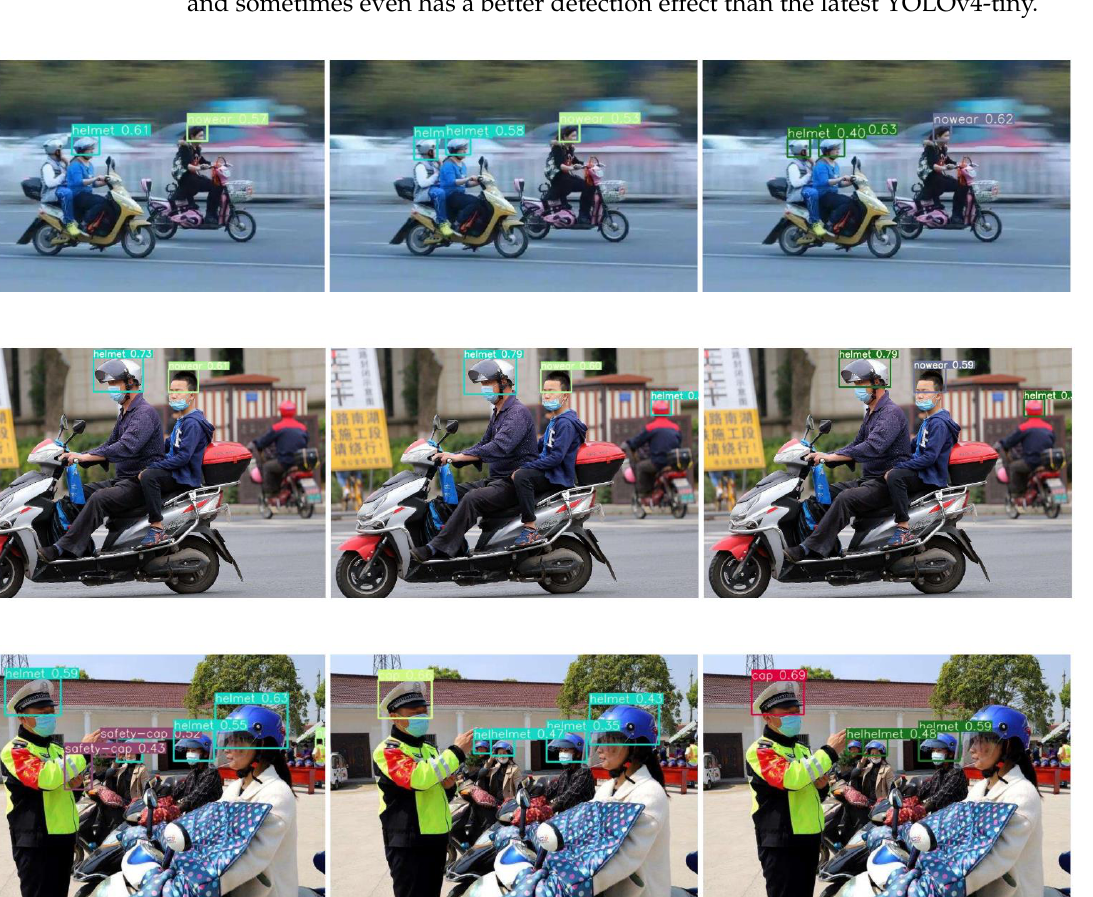
( b ) The curves of F1 Figure 6. The curves of F1 and mAP in the different models. 4.2.3. Result Comparison with Other Detection Models To prove each algorithm’s generalization performance, we compare and analyze dif- ferent evaluation indexes for different algorithms on the test set, which are shown as shown in Table 4. From Table 4, we can draw the following conclusions. On the test set, compared with the YOLOv3-tiny, SAS-YOLOv3-tiny improves R from 75.4% to 80.9% im- proves mAP from 74.6% to 80.3%, improves F1 from 72.9% to 75.2% and reduces the size of weight file from 69.5 MB to 46.9 MB, which mainly benefits from the use of SR module based on channel attention and SPP module, the application of three-scale prediction method, and the introduction of CIoU loss. Compared with the latest YOLOv4-tiny, SAS- YOLOv3-tiny improves R from 80.0% to 80.9% and improves mAP from 78.9% to 80.3%, but P and F1 decreases to some extent. The main reason is that the idea of the Cross Stage